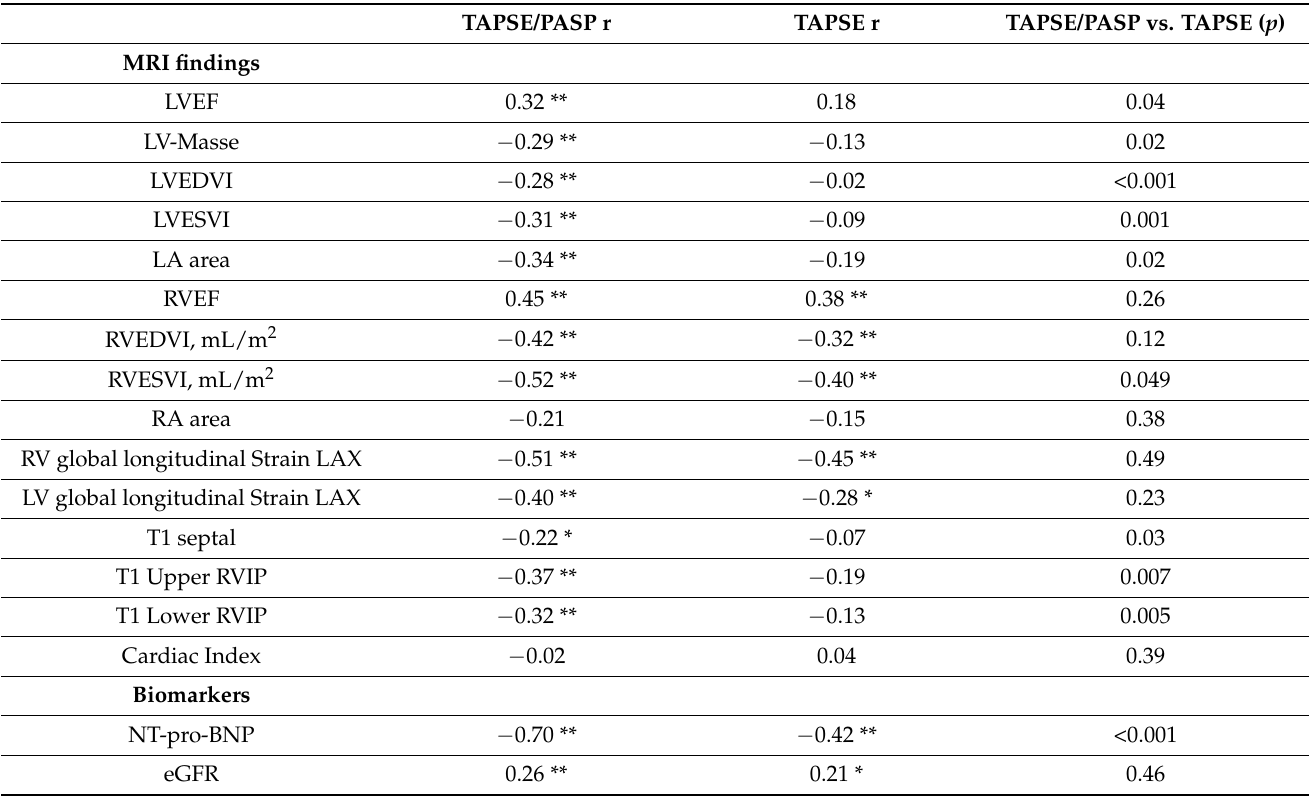
Table 2. Correlation analysis of the imaging